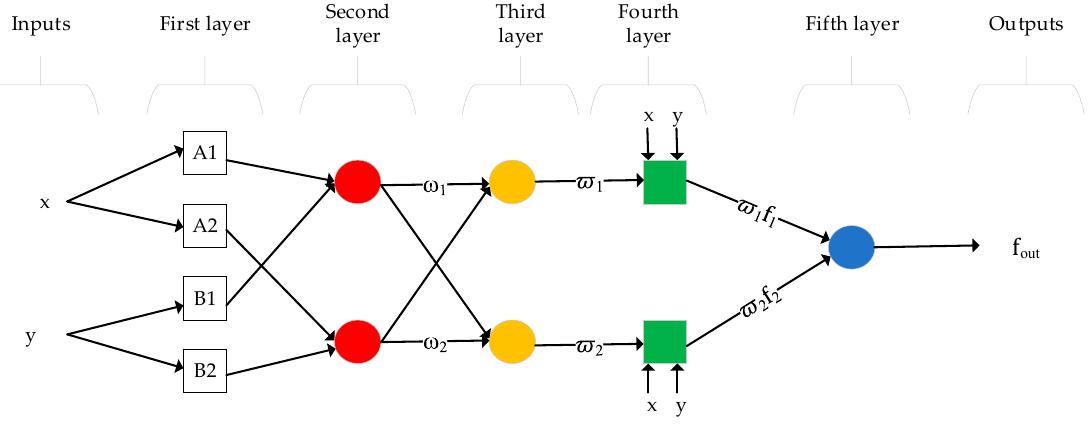
Figure 3. The architecture of adaptive network-based fuzzy inference system.